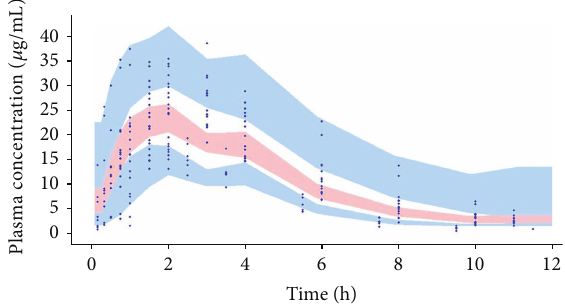
Figure 3: Visual predictive check. The figure shows the 90% prediction intervals obtained by simulation using the final model. The light blue areas are the 90% confidence intervals for the median, 5th percentile, and the 90th percentile of the simulated data. Circles represent observed